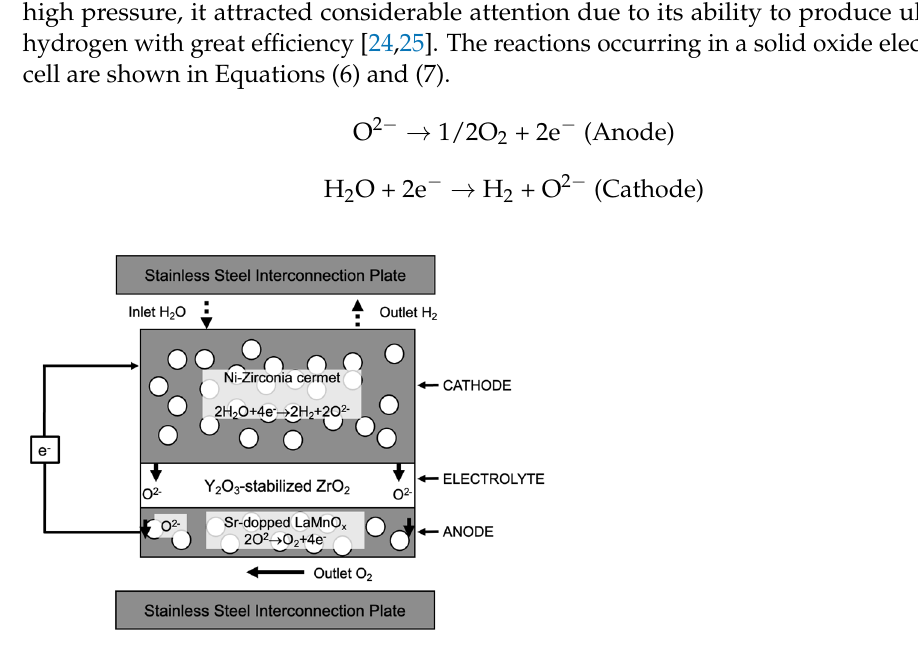
Figure 4. Scheme for HTEL, high-temperature solid oxide electrolysis. Reprinted with permission from [23].